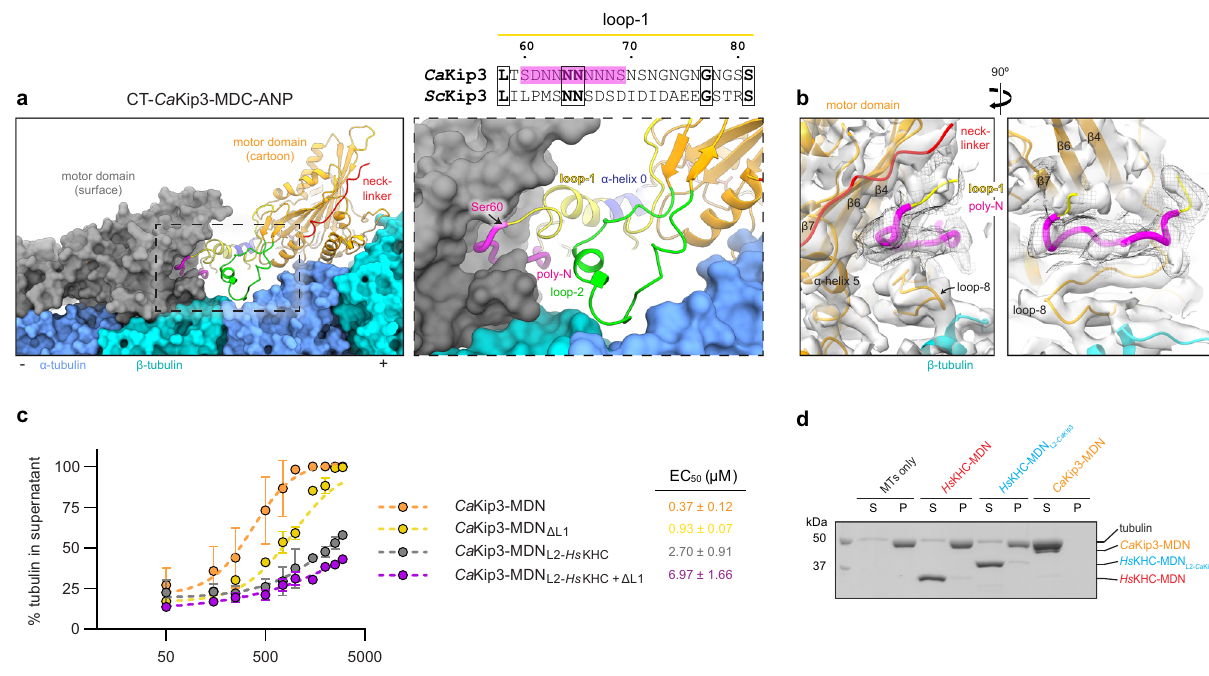
Fig. 6 Loop-1 and loop-2 are major contributors to microtubule depolymerization activity. a Cartoon representation of Ca Kip3 in the CT- Ca Kip3-MDC- ANP complex showing the polyasparagine section of loop-1 (magenta) inserted into the preceding motor domain (shown in surface representation). The insert shows “ close up ” view of the polyasparagine section in order to visualize structural elements involved in complex formation. Sequence alignment shows polyasparagine section of loop-1 in Ca Kip3 compared to Sc Kip3. b Cryo-EM map of the CT- Ca Kip3-MDC-ANP complex. A low-pass fi ltered map (5 Å) is shown as a black mesh around the polyasparagine track of loop-1. c Microtubule depolymerization by sedimentation dose-response curves for the indicated Ca Kip3 proteins. 2 µ M GMP-CPP-stabilized microtubules were incubated with increasing concentrations of Ca Kip3-MDN, Ca Kip3-MDN Δ L1 , Ca Kip3-MDN Ca Kip3-MDN fi t to the four- L2- Hs KHC , or L2- Hs KHC + Δ L1 in the presence of ATP. The data from three independent experiments were analyzed and parameter logistic equation. Mean values (±SD) are shown. EC 50 values are presented as the mean ± SEM. d Depolymerization of 2 µ M GMP-CPP- stabilized microtubules by 3 µ M of Hs KHC-MDN, 3 µ M Hs KHC-MDN L2- Ca Kip3 , and 1 µ M Ca Kip3-MDN assessed by sedimentation. Reactions